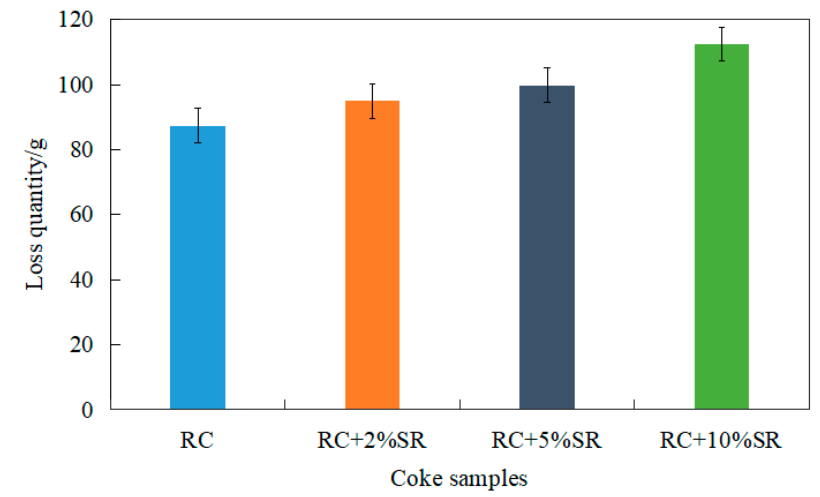
Figure 10. The loss quantity of the coke samples. Energies 2021 , 14 , x FOR PEER REVIEW